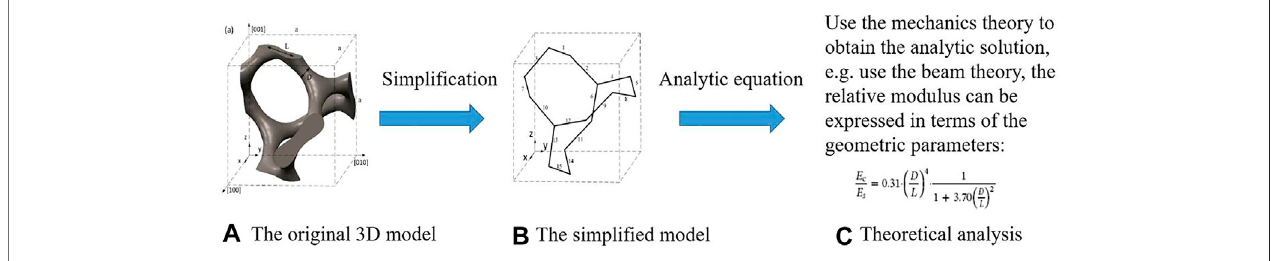
FIGURE 5 | The analysis procedure for obtaining the properties of Gyroid structure using the analytical method (adapted from Yang et al., 2019).